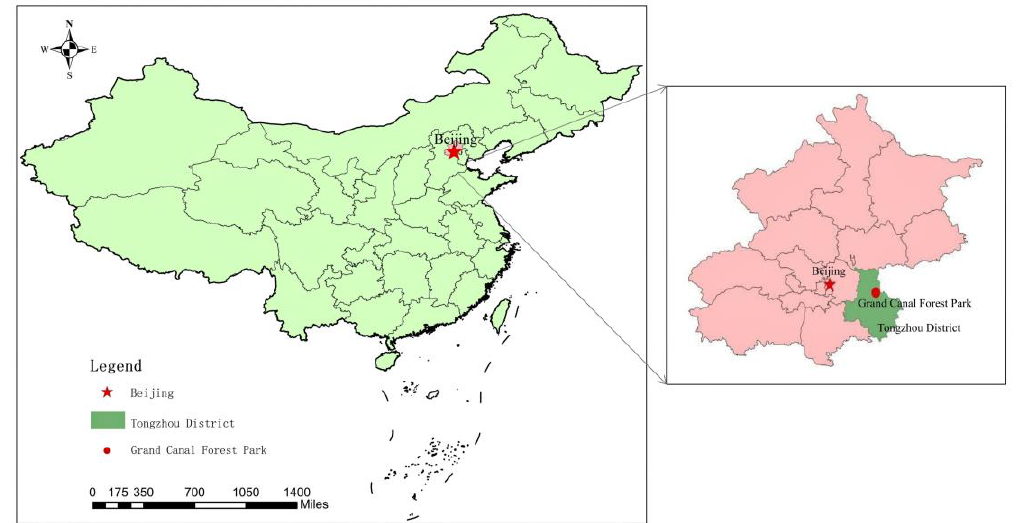
Figure 2. Location of the Grand Canal Forest Park in Tongzhou District, Beijing.